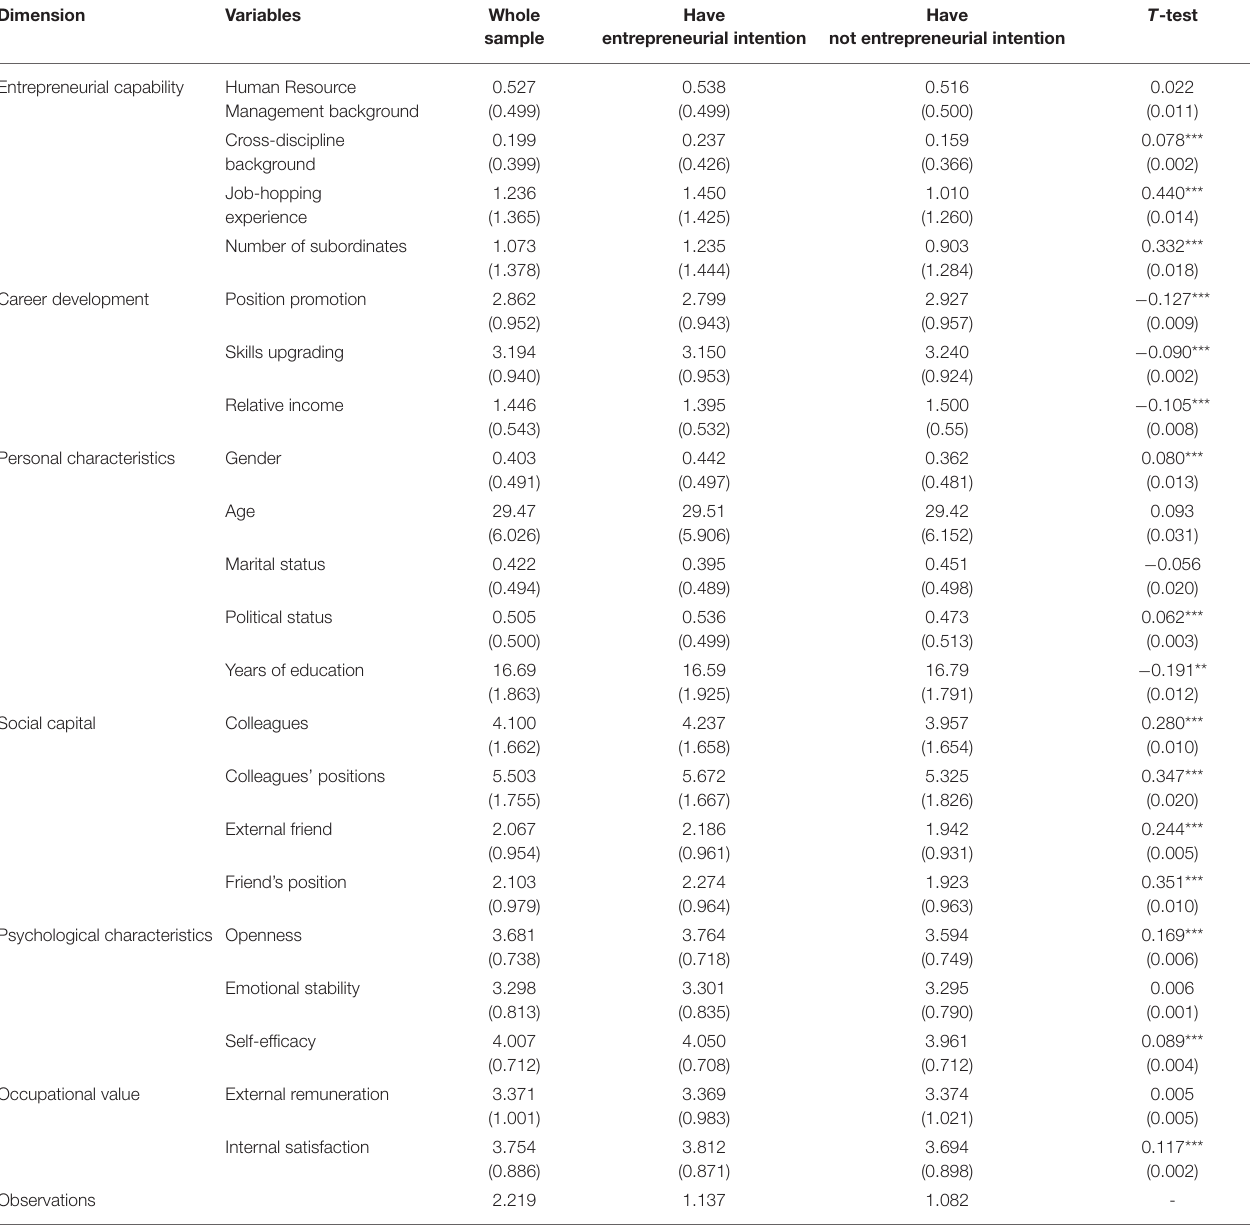
TABLE 2 | Descriptive statistics of the main variables.